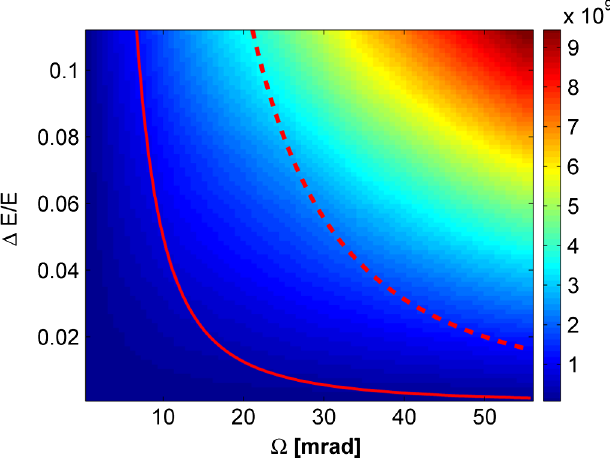
FIG. 12. Contour plots for usable intensities of 400 MeV = u carbon ions with curves of constant chromatic